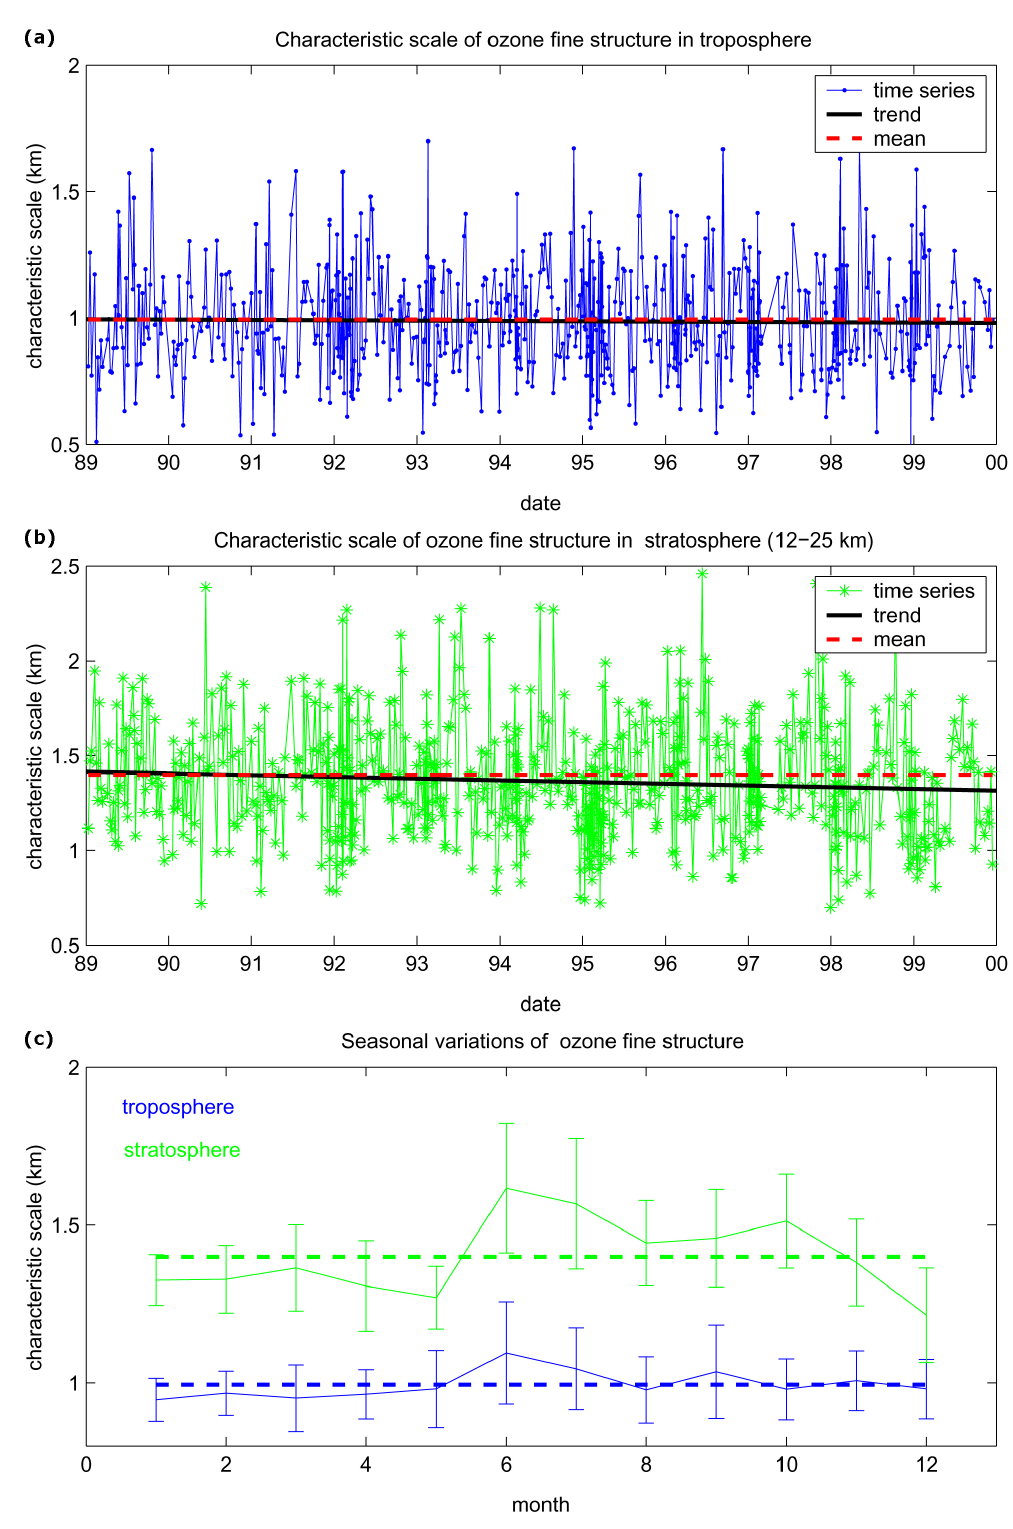
Fig. 2. ( a , b ) 11-year time series of the characteristic scale of the fine ozone structure, dashed red lines: mean characteristic scales, solid black lines: trends; ( c ) Seasonal variations of the characteristic scale of ozone fine structures. Solid lines: monthly mean values with 1 σ uncertainty interval, dashed bold lines: mean over the time series values for the troposphere (blue) and the lower stratosphere 12 − 25km